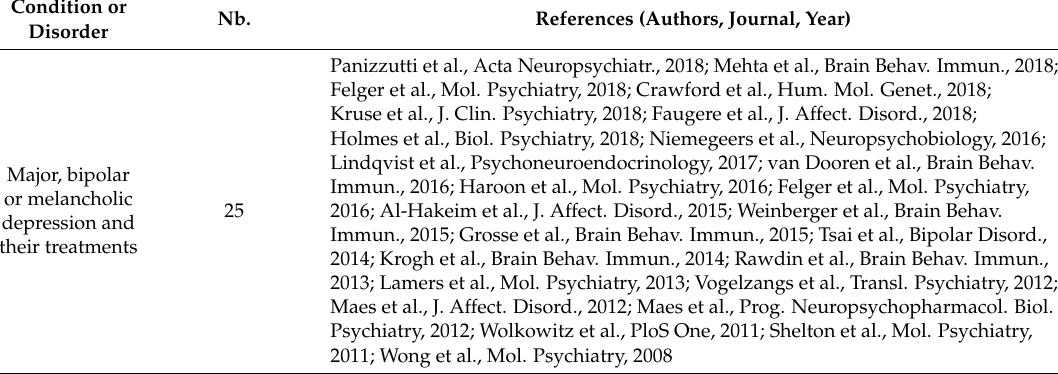
Table 1. Number of Pubmed articles reporting original research with inflammation and depression in their titles and classified according to somatic conditions or mental